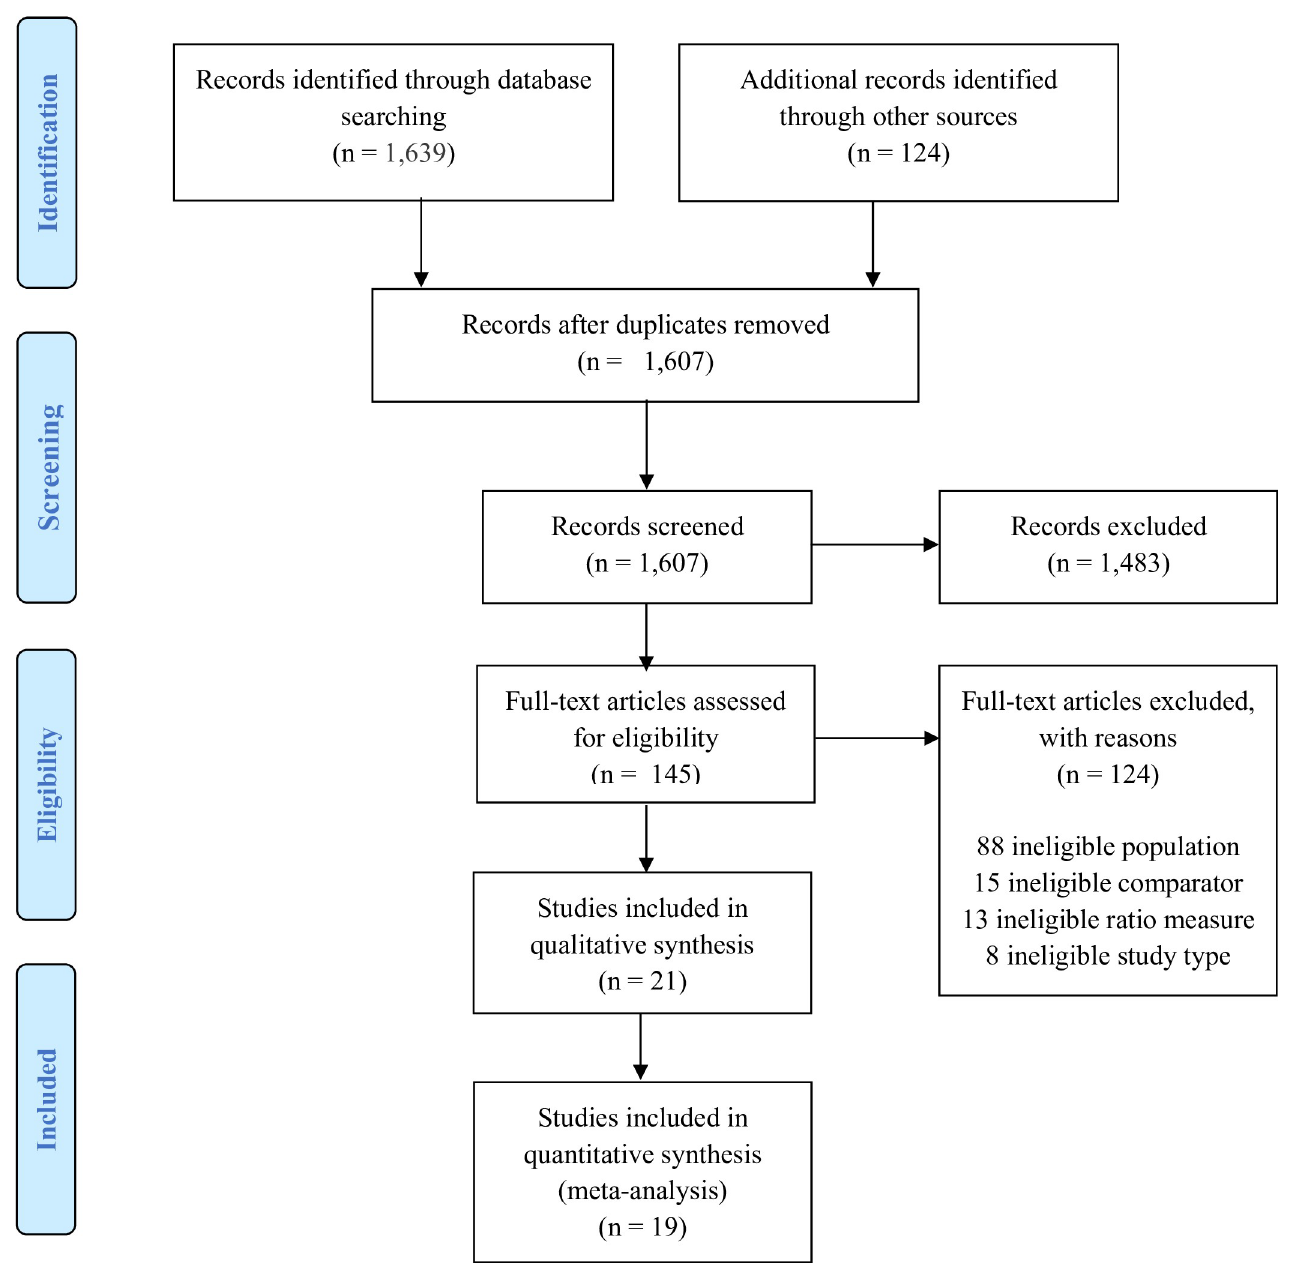
Fig 1. Flow diagram of study